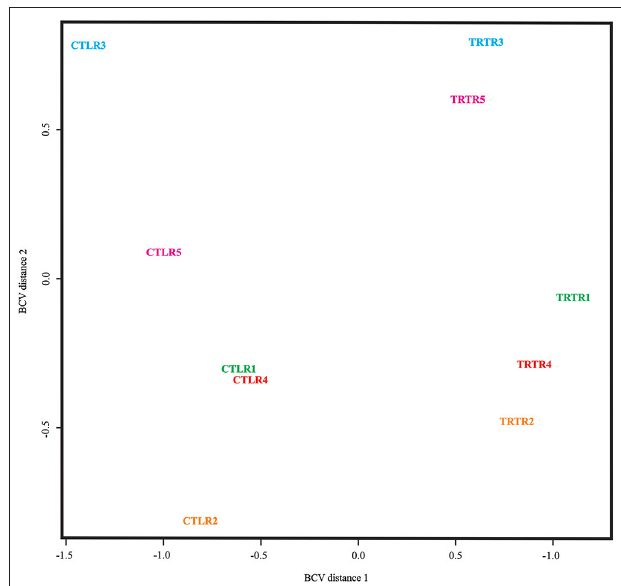
FIGURE 2 | Multidimensional scaling relationship between M. glaucescens explants before (CTL) and after (TRT) shoot organogenesis induction. In the plot, the biological coefficient of variation (BCV) dimension 1 separates control and treated samples; whereas BVC dimension 2 separates the genotypes.